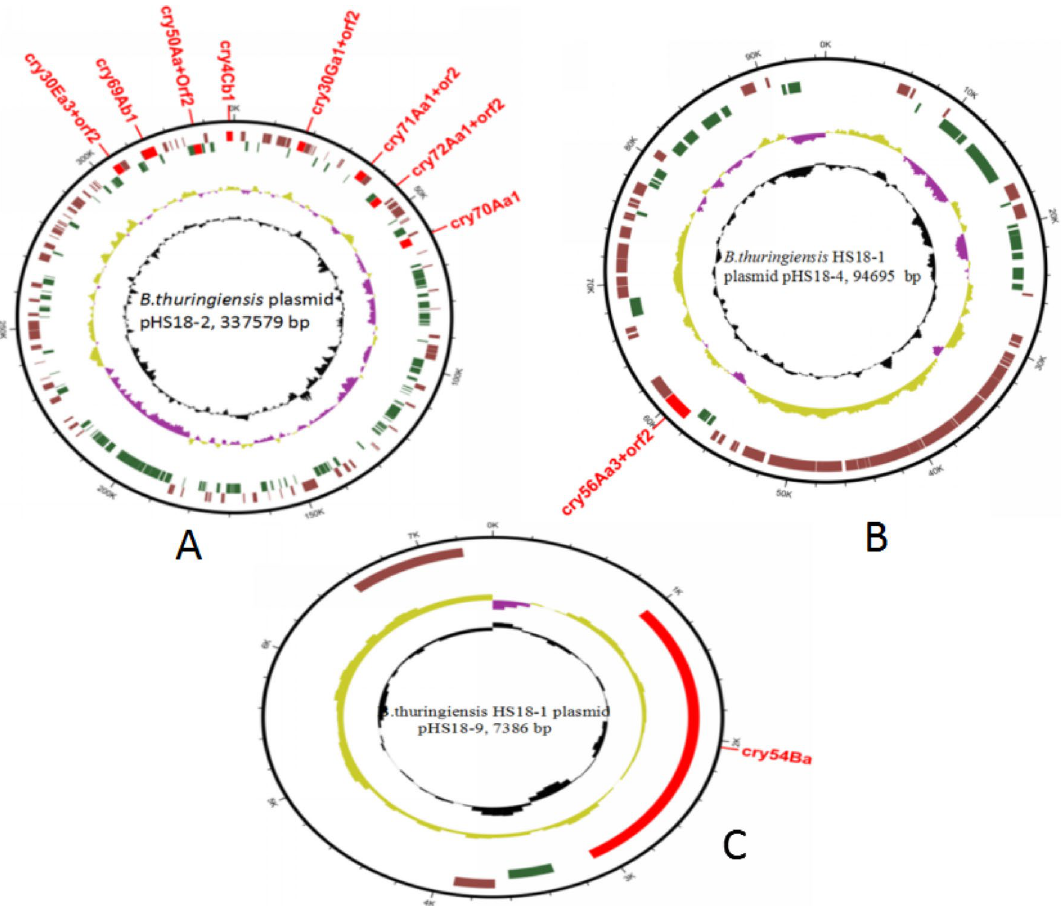
Figure 3. Circular representation of plasmids pHS18-2, pHS18-4 and pHS18-9. ( A ) Circular representation of plasmid pHS18-2 displaying relevant genome features. ( B ) Circular representation of plasmid pHS18-4 displaying relevant genome features. ( C ) Circular representation of plasmid pHS18-9 displaying relevant genome features.